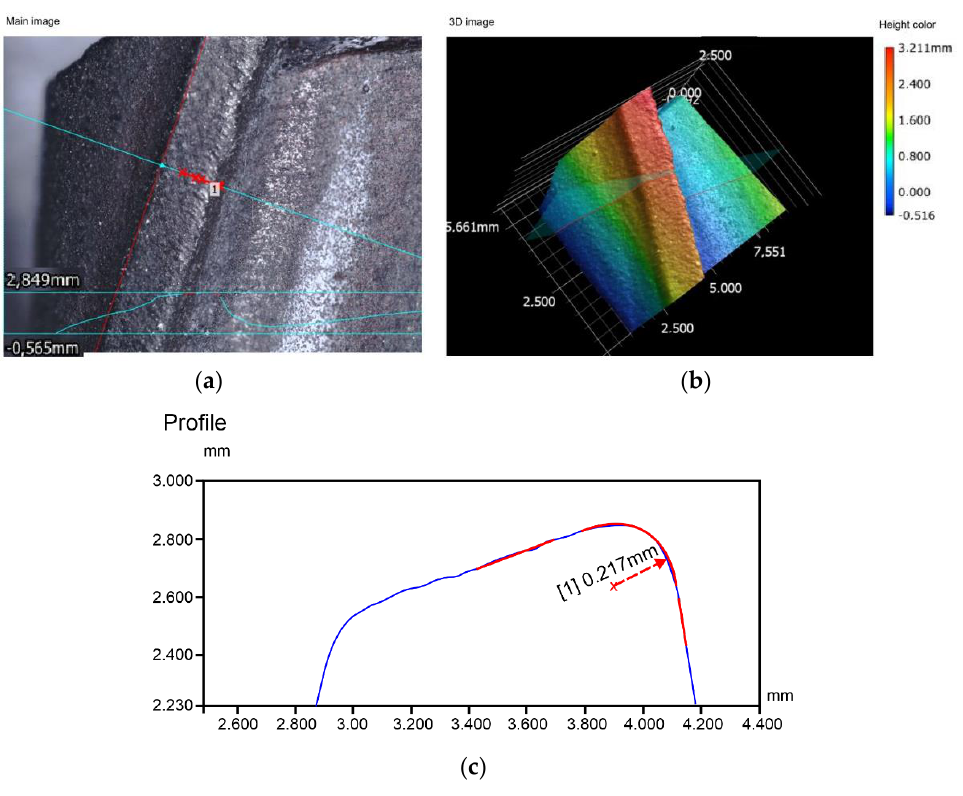
Figure 11. Measurement of the cutting edge radius, ( a ) scan image of the area measured, ( b ) digital image of the area measured, ( c ) edge profile.